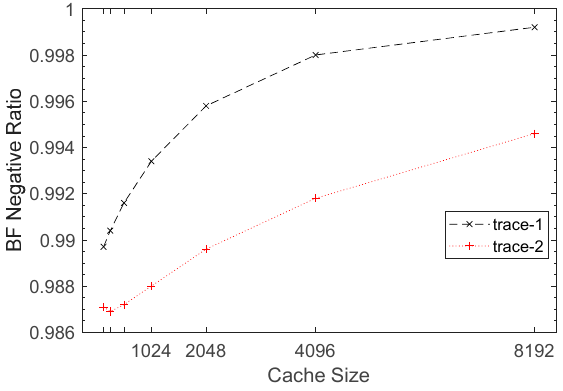
Figure 11. The negative ratio of a Bloom filter.